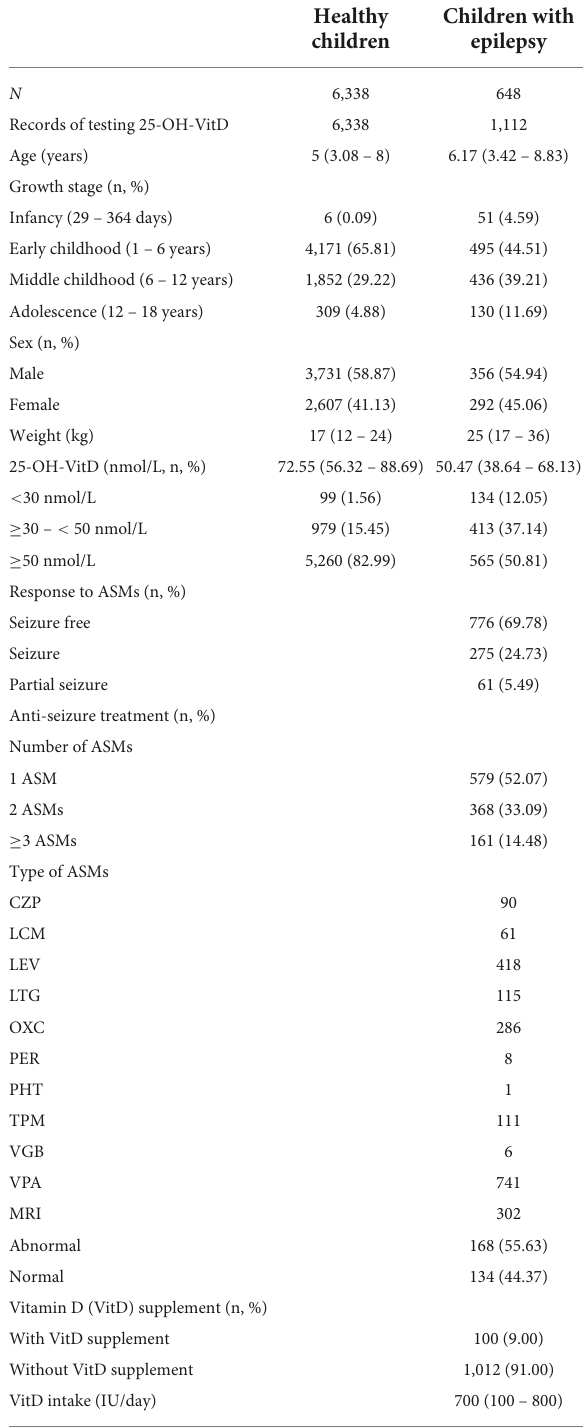
TABLE 2 Demographic characteristics of healthy children and pediatric patients with